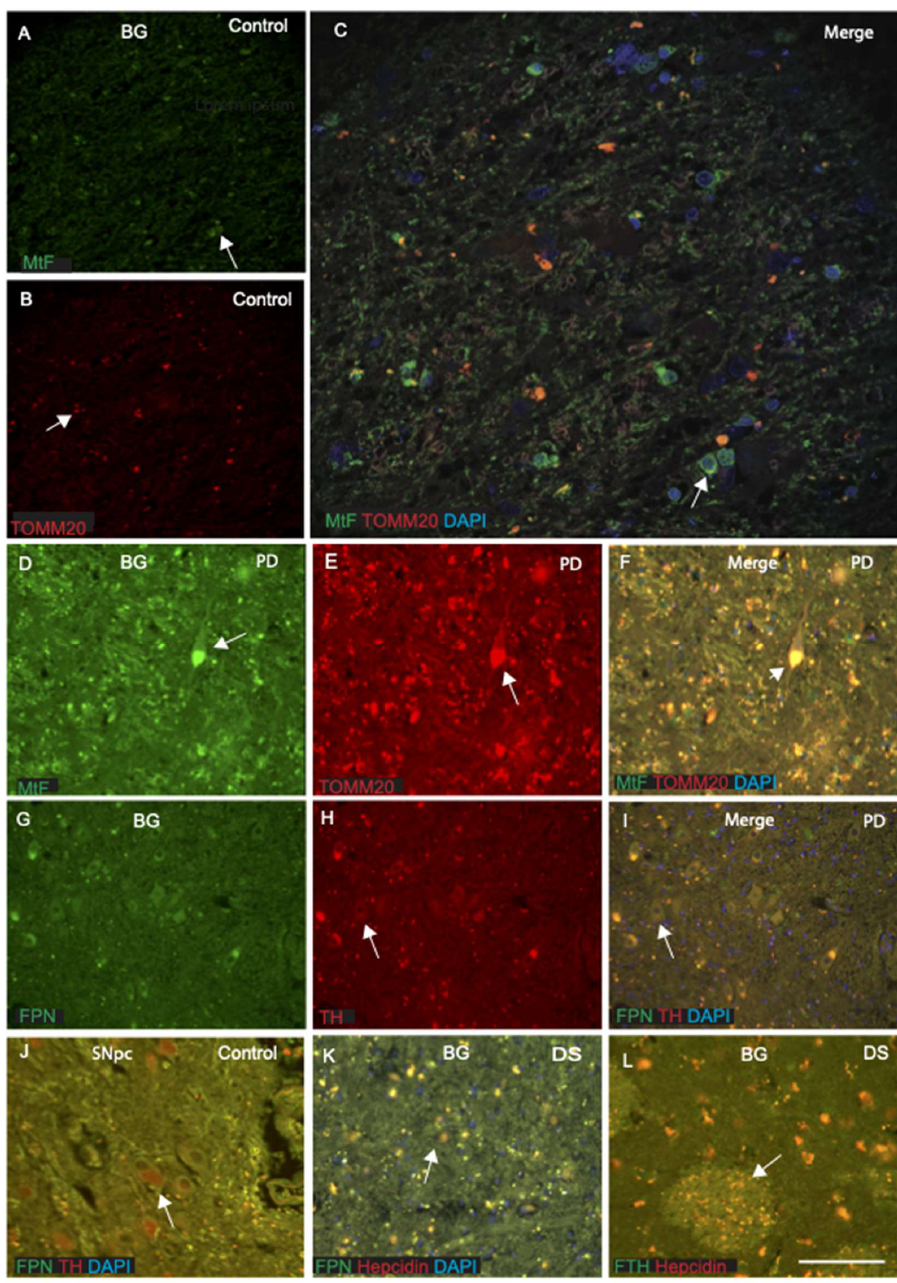
Figure 7. Blood vessel damage and basal ganglia pathology in AD, PD, and ageing brain. Brain sections from basal ganglia were double-labelled with MtF and TOMM20 using IFC and counter- stained with DAPI and analysed using confocal microscope. The MtF showed immunoreactivity for the cell bodies and fibres of the caudate nucleus, and some co-localised with TOMM20 ( A – C ). On higher magnification, MtF was visible in the neuronal fibres of striatal matrix ( C ). In PD brain section, both proteins co-localised in the striosomes and matrix ( D – F ). A control brain section from the SNpc ( J ) and a section from PD brain were stained with ferroportin and tyrosine hydroxylase (TH); in control brain, dopamine cells were filled with TH proteins (red) ( J ), whereas in PD brain, dopamine neurons were empty, but ferroportin staining was visible in the striatal matrix ( G – I ). Two basal ganglia sections were stained, ferroportin and hepcidin expressed in the thalamo-striatal fibres in the DS brain ( K ) and fibre bundles were positive for ferroportin. DS brain sections stained with FTH and hepcidin showed patch-like terminal field of the thalamo-striatal projection in the putamen with co-localisation of both proteins ( L ). Scale bar: ( A – F ) = 10 µ m, ( G – L ) = 25 µ